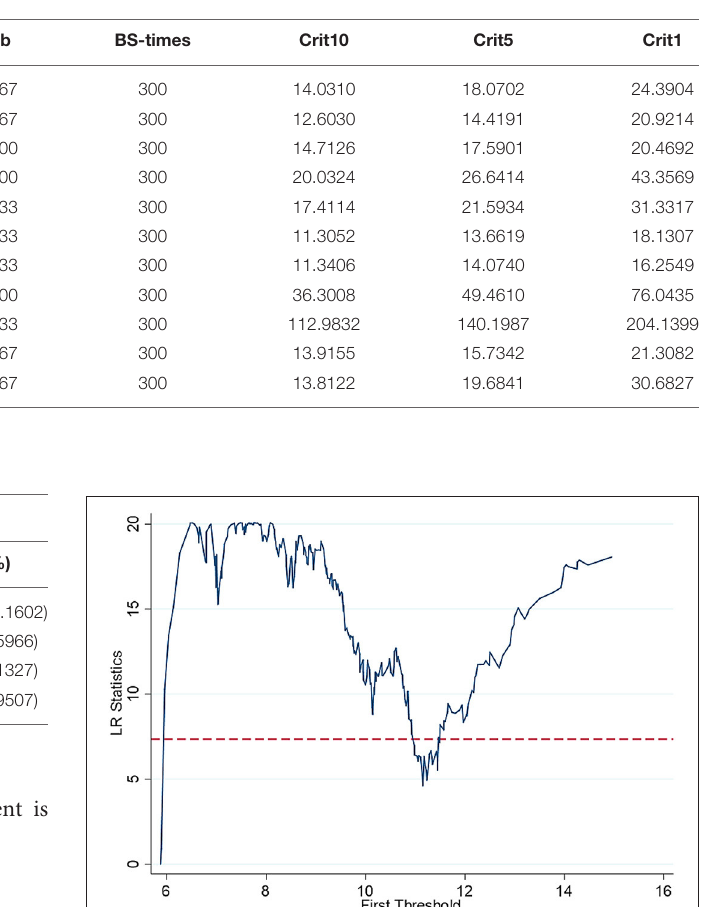
TABLE 4 | Test for threshold.